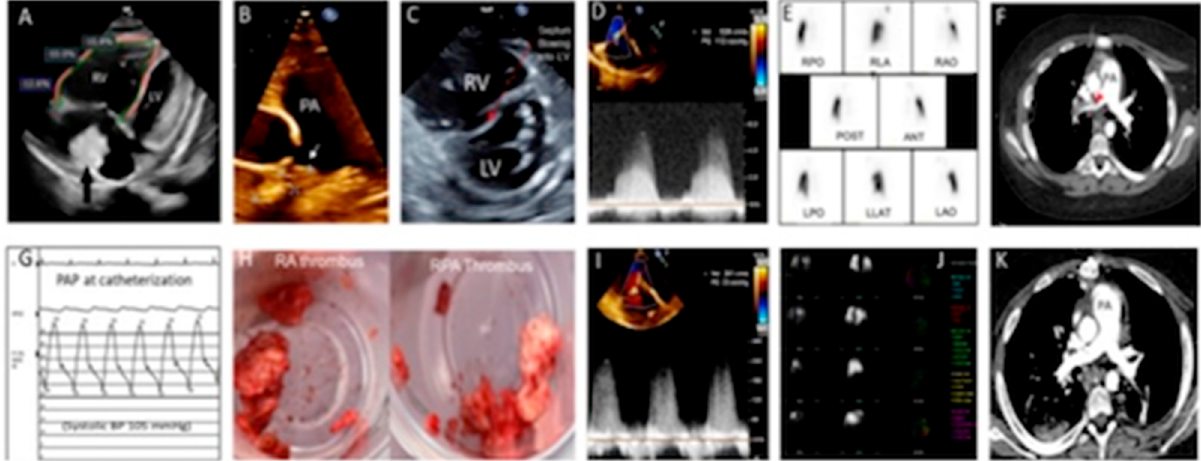
Figure 2. ( A ) Four-chamber view showing dilated RV, decreased RV global longitudinal strain, RVEF (43%) by 3-D, and a large thrombus (measuring 34 mm × 26 mm) in RA; ( B ) 2-D echocardiogram showing mild dilated pulmonary artery (26 mm) and a large thrombus measuring 26 mm × 12 mm occluding RPA; ( C ) parasternal short-axis view showing dilated RV with inter-ventricular sep- tum bowing into LV in systole suggesting supra-systemic RV pressure; ( D ) TEE prior to surgery showing RV systolic pressure 112 mmHg plus RA pressure (systemic systolic BP was 105 mmHg); ( E ) ventilation-perfusion (V–P) scan prior to pulmonary artery endarterectomy (PAE) showed large unmatched perfusion defect in entire right lung and decreased perfusion of mid lower left lung; ( F ) computed tomography pulmonary angiography (CTPA) showed a large thrombus in RPA, occlud- ing blood flow to right lung; ( G ) at right heart cardiac catheterization while on 100% oxygen and iNO, PAP was 58/29, mean 40 mmHg; ( H ) thrombus removed from RPA and RA; ( I ) immediately after PAE RV, systolic pressure based on TR velocity obtained by TEE was significantly decreased to 23 mmHg plus RA pressure; ( J ) post-PAE repeat VP scan showed improved perfusion defects in right lung and mid lower left lung; ( K ) post-PAE repeat CTPA showed no thrombus in RPA and no new emboli.